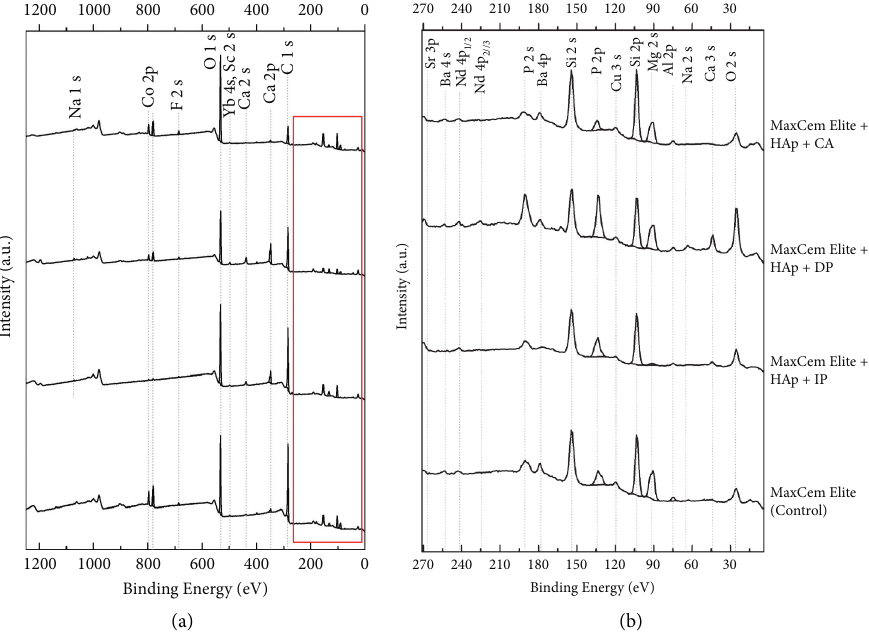
Figure 2: Survey spectra of (from bottom to top) Maxcem Elite (control), Maxcem Elite+HAp+IP, RelyX U200+HAp +DP, and RelyX U200+HAp +CA. On the left (a), survey spectra are presented, while on the right (b) is a zoom-in of the region defined in red. Table 3: Elemental distribution in atom % in the experimental groups as a function of the curing protocols used in the present study. Concentration of the elements (atom %) O Hydroxyapatite RelyX